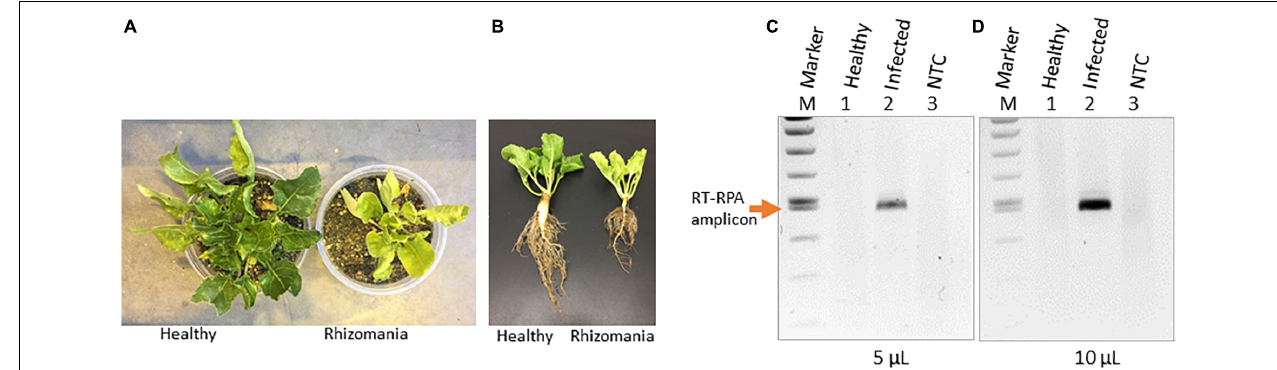
FIGURE 1 | Rhizomania baiting and RT-RPA-mediated detection of BNYVV from B. vulgaris . (A) Whole-plant pictures of B. vulgaris baited for rhizomania under greenhouse condition in pots using infected field soil 6 weeks post inoculation. (B) Representative individual plants showing root phenotype associated with rhizomania. Extreme care was taken to gently remove the soil from root. (C,D) Detection of RT-RPA amplicon on agarose gel. Even 5 µ l (C) and 10 µ l (D) loading volumes show strong visual band from a 50- µ l reaction. Lanes: Infected refers to sugarbeet roots baited for rhizomania disease from field soil. Healthy refers to root obtained from sugarbeet grown in potting mix used for growing plants under laboratory conditions. NTC stands for no template control, and M stands for size marker.